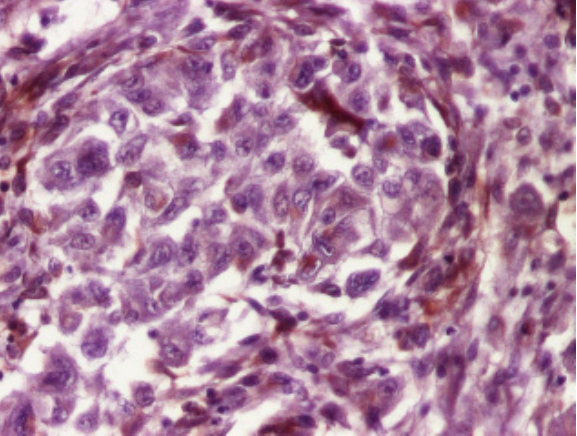
Figure 8. The tumor cells showed no expression of vimentin, ×200.